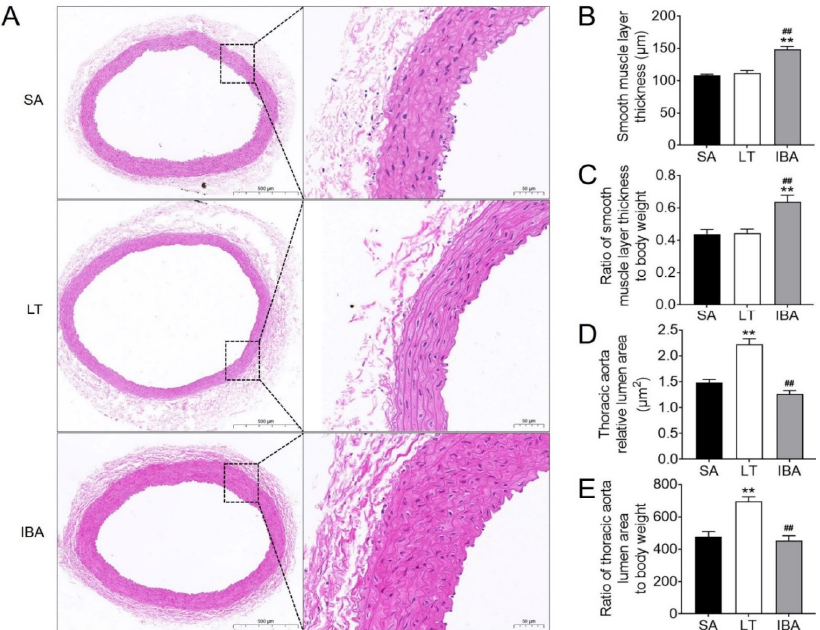
Figure 3. HE staining of the thoracic aorta in ground squirrels. ( A ) Typical images of HE staining. The scale in the left column is 500 µ m and the scale in right column is 50 µ m. ( B ) Smooth muscle layer thickness was measured at three random locations in each thoracic aorta. ( C ) The ratio of the mean value of smooth muscle layer thickness to body weight was determined for three random locations in each thoracic aorta. ( D ) Lumen area of the thoracic aorta. ( E ) Ratio of lumen area of thoracic aorta to body weight. SA: summer active, LT: late torpor, IBA: interbout arousal. Mean ± SEM. n = 6. Significant a difference from SA conditions is denoted as ** p < 0.01, whereas a significant difference in IBA as compared with LT is denoted by ## p <